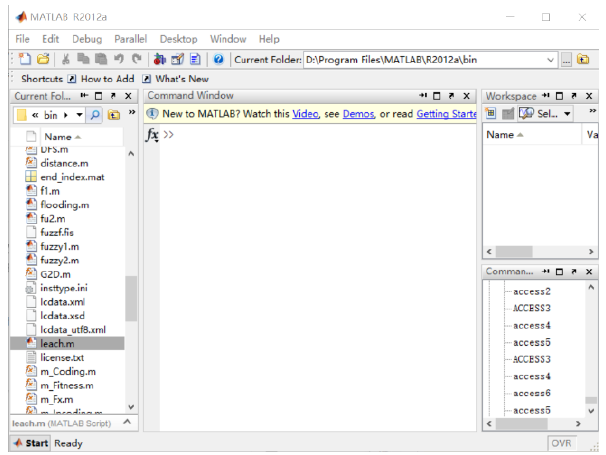
Figure 7. The MATLAB workspace.